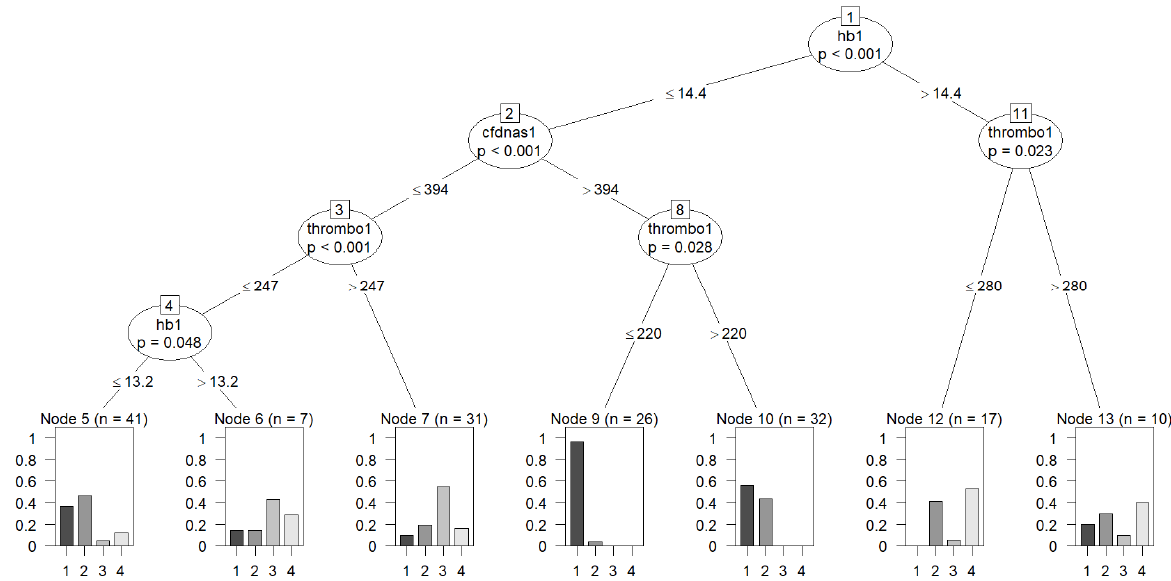
Figure 6. Decision tree for differentiation of all disease groups: group 1 = severe multiple trauma, group 2 = moderate multiple trauma; group 3 = femur neck fracture; group 4 = ankle fracture. hb1 (hemoglobin); cfdnas1 (cfDNA in serum); thrombo1